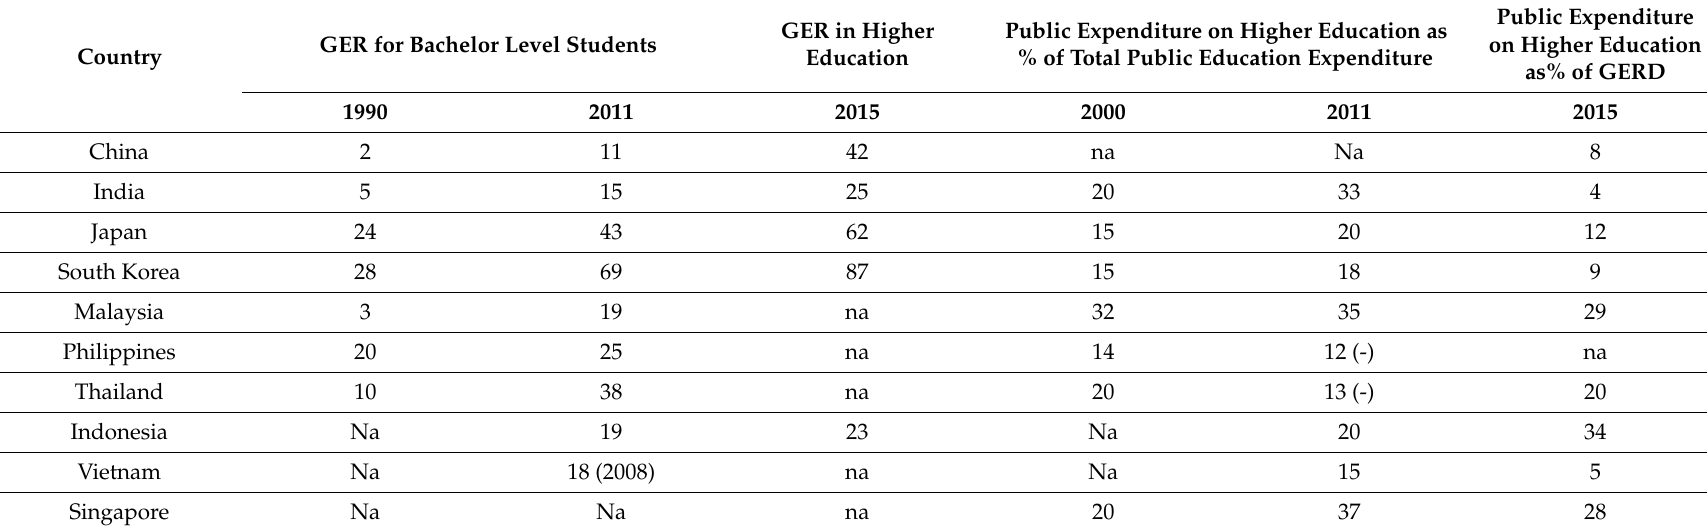
Table 1. Higher education: gross enrolment ratio and